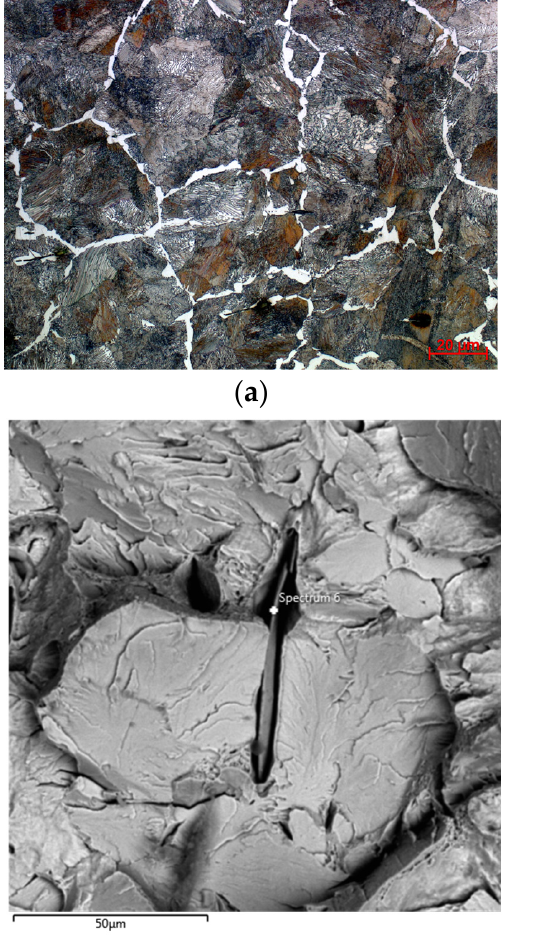
Figure 6. Rail microstructure ( a ) and non-metallic inclusions (highlighted in red) in the longitudinal section ( b ); photograph ( c ) and EDX-spectrum ( d ) of a nonmetallic sulfide inclusion revealed in a fracture of a rail fragment by EDX-analysis.